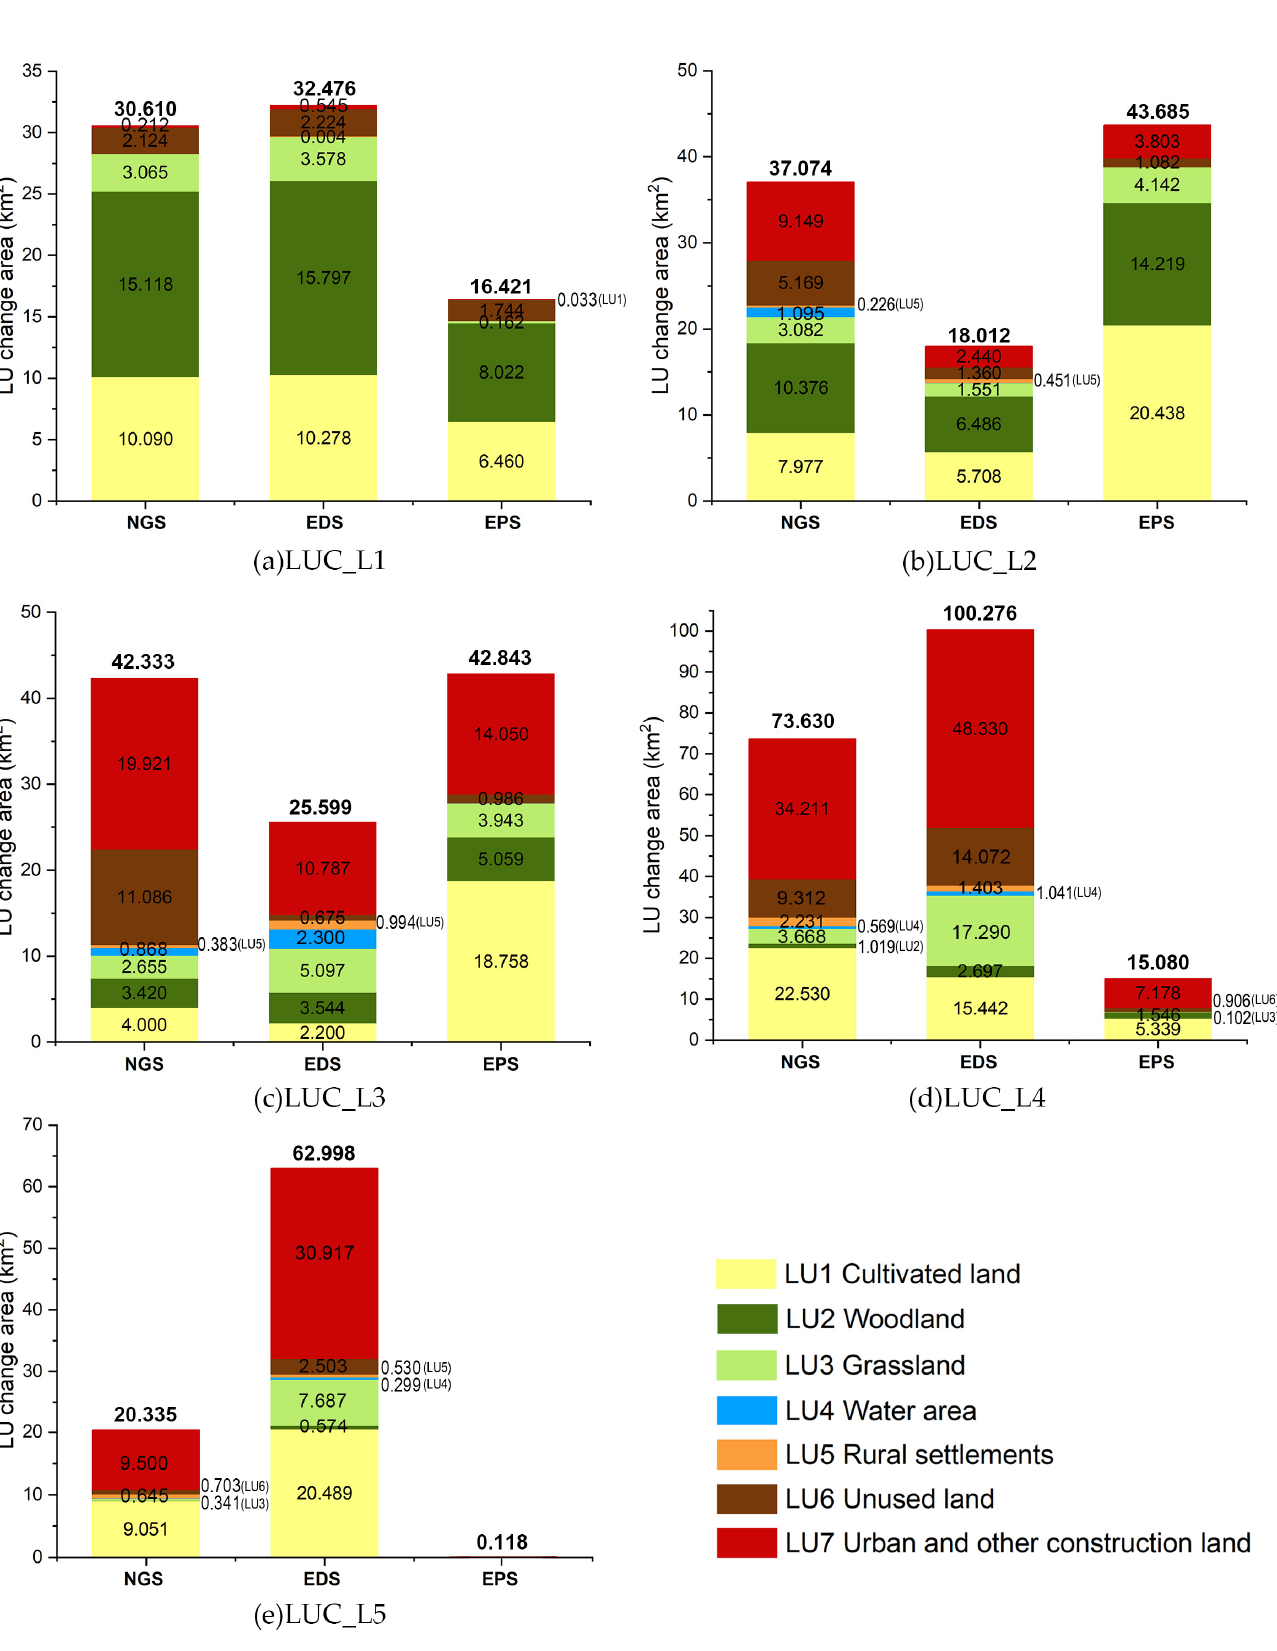
Figure 12. Land use transition area at each LUC level under different scenarios.